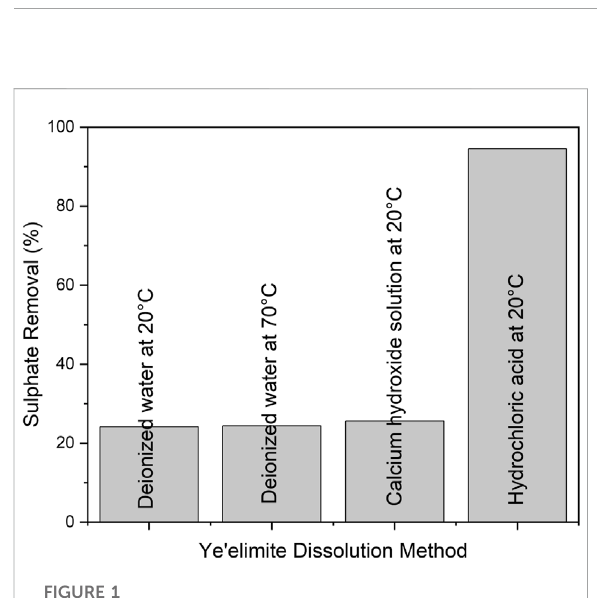
FIGURE 1 Percentage of sulphate removal from the synthetic wastewater using different ye ’ elimite dissolution